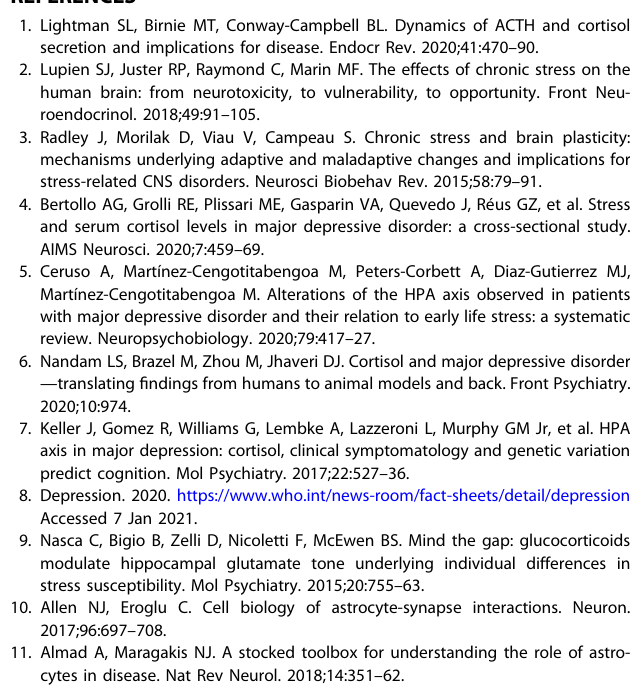
Fig. 3 Chronic cortisol treatment elicts a unique transcriptional response in astrocytes derived from patients with MDD. a Schematic showing the process of deriving astrocytes from Major Depression (MDD) patient skin samples and treatment with chronic cortisol for RNA- sequencing. b Bright fi eld representative images of astrocytes differentiated from 3 healthy control individuals and 6 MDD patients; scale bar = 100 µm. c Quanti fi cation of astrocyte marker expression measured via immunostain. Bars show mean ± SEM, n = 6 individuals (individuals are represented by dots). d Principal component analysis of transcriptome sequencing data in all treated samples; black dots = healthy individuals, blue dots = MDD individuals. e Volcano plots depicting differentially expressed genes (DEGs) upregulated (green dots) or downregulated (purple dots) following treatment with cortisol; n = 3 (Healthy); n = 6 (MDD). f Venn diagram comparison of DEGs unique to each cohort and those that overlap. g Selected highly signi fi cant genes regulated by chronic cortisol in both healthy and MDD individuals with top gene ontology categories, left. h Top gene ontology categories from DEGs unique to MDD (287 genes); bars represent the logPvalue of the term and numbers within the bar represent the genes in our list under that term. i Selected highly signi fi cant genes in top GO categories unique to MDD con fi rmed by RT-qPCR; bars show mean log 2 fold change over vehicle ± SEM for n = 6 (individuals are represented by